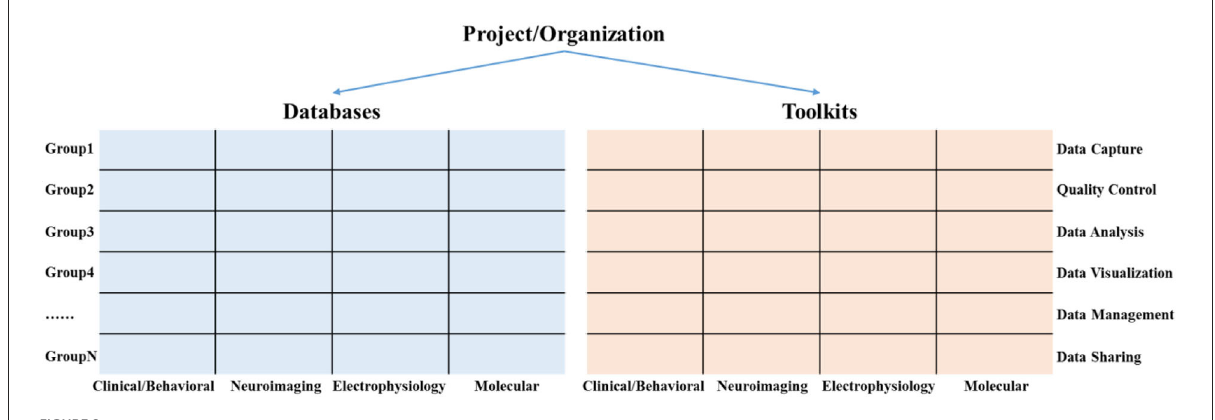
FIGURE2 A hierarchical knowledge base framework consists of projects, databases, and